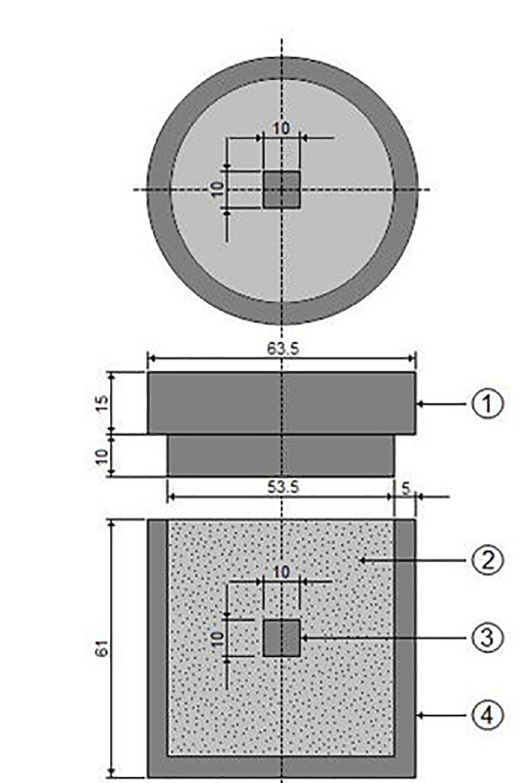
Figure 2. Schematic view of the stainless steel AISI 304L container for the pack-powder boriding treatment (1: lid; 2: powder boriding medium (B C + KBF + SiC); 3: sample; 4: container) 4 4